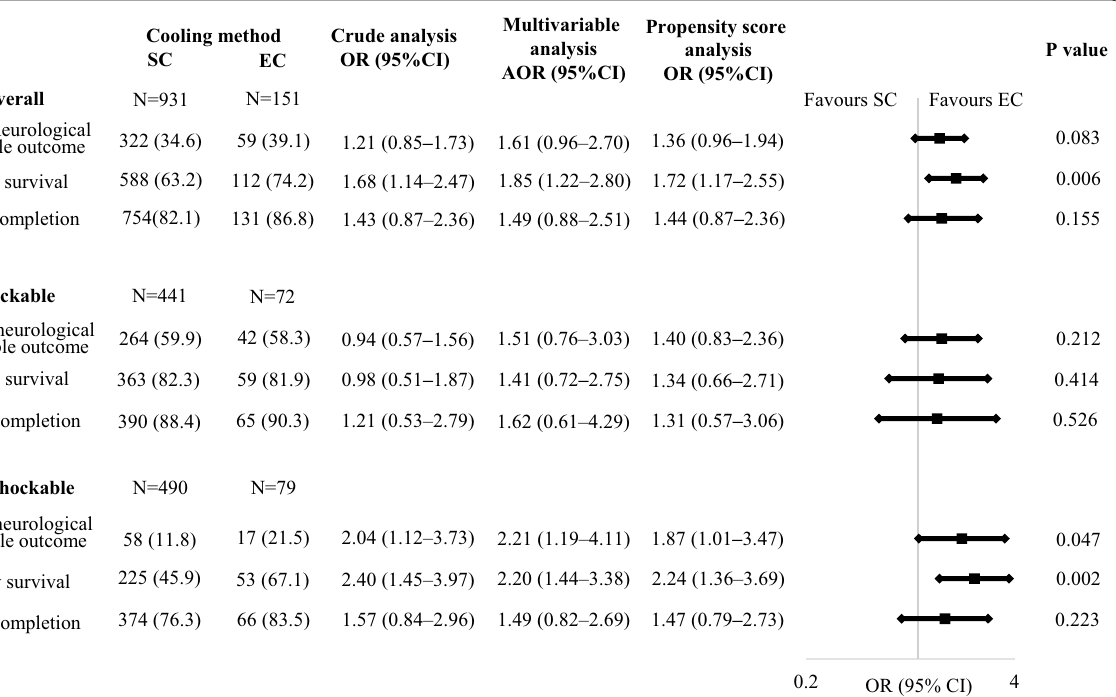
Fig. 2 Outcome of the study population according to the cooling method. Values are expressed numbers (percentages) unless indicated otherwise. TTM target temperature management, SC surface cooling, EC endovascular cooling, OR odds ratio, AOR adjusted odds ratio, CI confidence interval. “EC” includes patients receiving both EC and SC methods. *Shown is the adjusted odds ratio from the multivariable random effects logistic regression analysis with hospital treated as a random effect, with stratification according to age, sex, cause of arrest, bystander witness, bystander CPR status, use of public-access AEDs, prehospital adrenaline administration, prehospital advanced airway management, EMS response time, target temperature and induction time of TTM. † Shown is the odds ratio from the univariable logistic regression analysis with inverse probability weighting according to the propensity